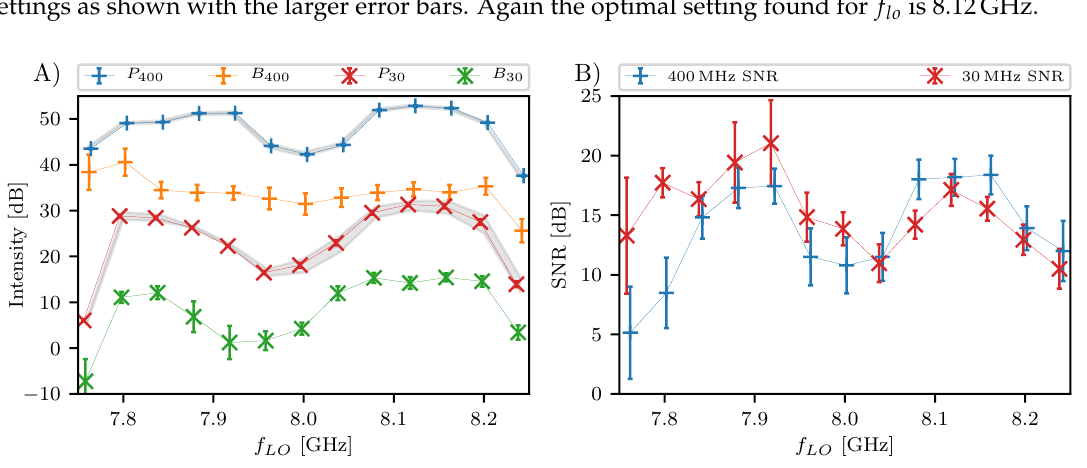
Figure 5. ( A ) Peak intensity of cable length ( P ) and averaged background ( B ) in a 90m loop test setting for different f lo frequencies and both measuring modes. Error bars are two standard deviations wide. ( B ) Signal-to-noise ratio between cable peak P and background intensity B for the research mode with 400MHz ramp (blue) and the detection mode with 30MHz ramp